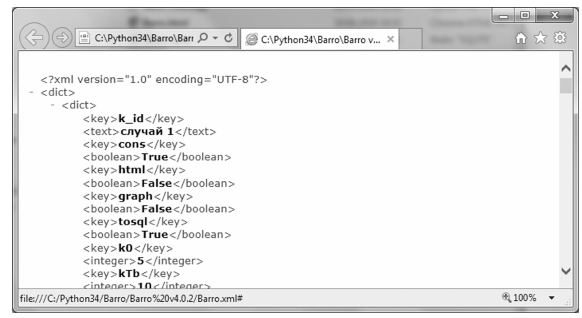
Model based on the Barro production function was used for construction of the system [13]. This model al- lowed to minimize the input parameters and get enough quick and clear result.